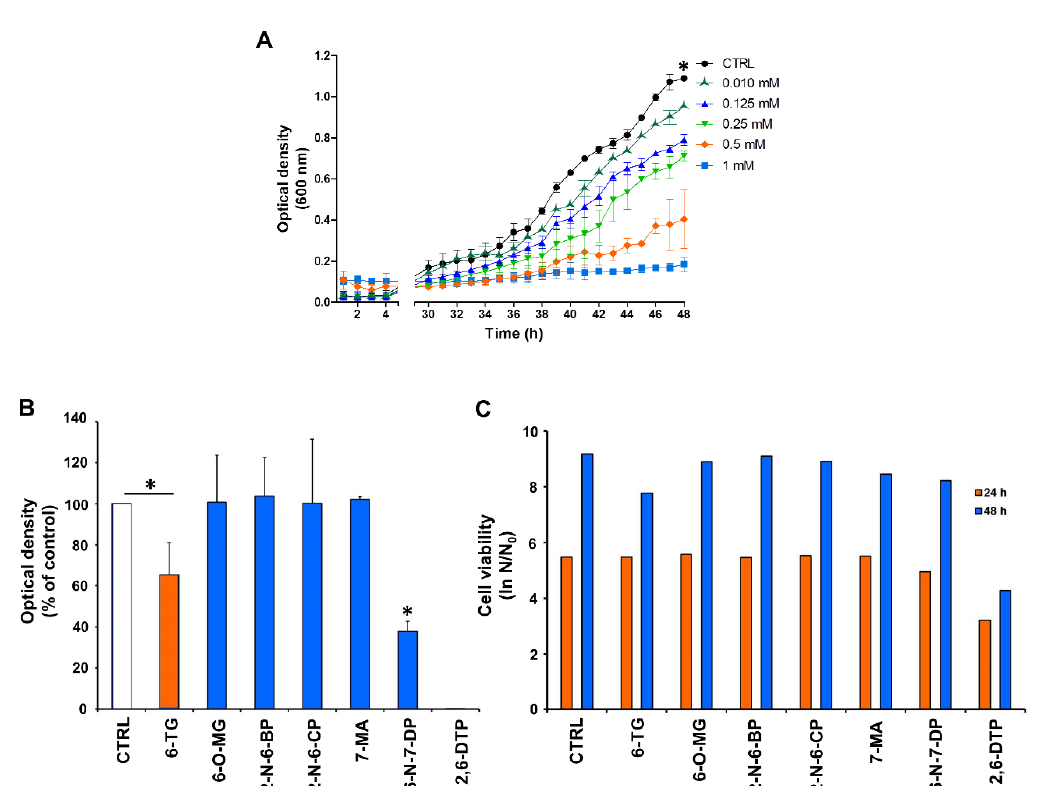
Figure 2. 6-TG and its analogues 6-amino-7-deazapurine (6-N-7-DP) and 2,6-dithiopurine (2,6-DTP) impair cell growth of Saccharomyces cerevisiae yeast cells. ( A ) Yeast cells were treated with the indicated concentrations of 6-TG or with NaOH as control (black curve) and optical density was measured at 600 nm every hour up to 48 h. Each point represents the mean ± SD from cells of triplicate wells. Statistical significance di ff erence with * p < 0.001, when comparing control with 1 mM, 0.5 mM, 0.25 mM and 0.125 mM, two-way ANOVA, Bonferroni post-hoc test. ( B ) Cell growth and viability in the presence of 6-TG and its analogues at 0.5 mM. Optical density at 48 hours was reported as percentage of control. The mean of three independent experiments ± SD was reported. Statistically significant di ff erence with *, p < 0.05, when comparing control with 6-TG or 6-N-7-DP, and 6-TG with 6-N-7-DP, one-way ANOVA and Tukey’s multiple comparison post-hoc test. ( C ) Viability at 24 and 48 h of control and drug-treated cells was measured by counting colony forming units after two days of growth on Yeast Extract-Peptone-Dextrose (YPD) plates. N refers to the number of cfu at the indicated time, N 0 refers to the number of cfu at time 0. Results from a typical experiment are shown.